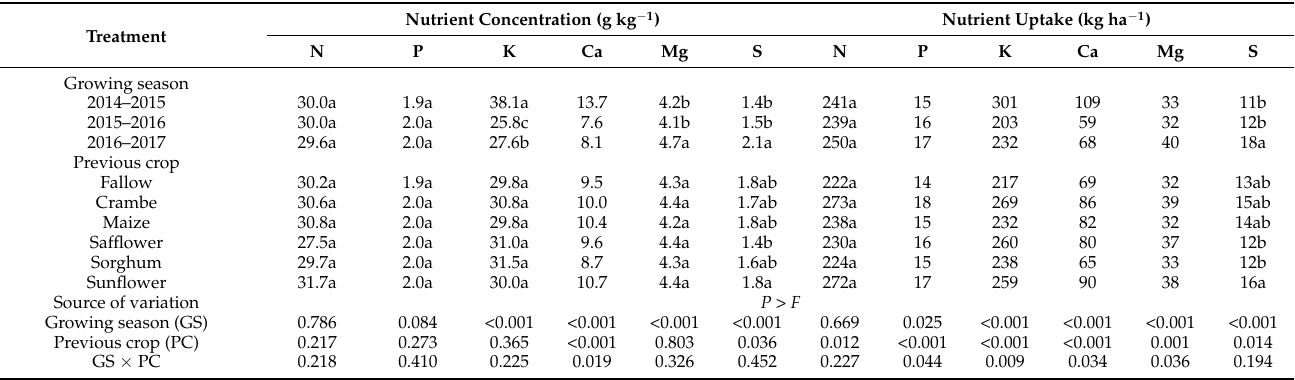
Table 3. Aboveground nutrient concentrations and uptake of spring–summer soybean crop following different fall–winter crops in three growing season, and analyses of variance.